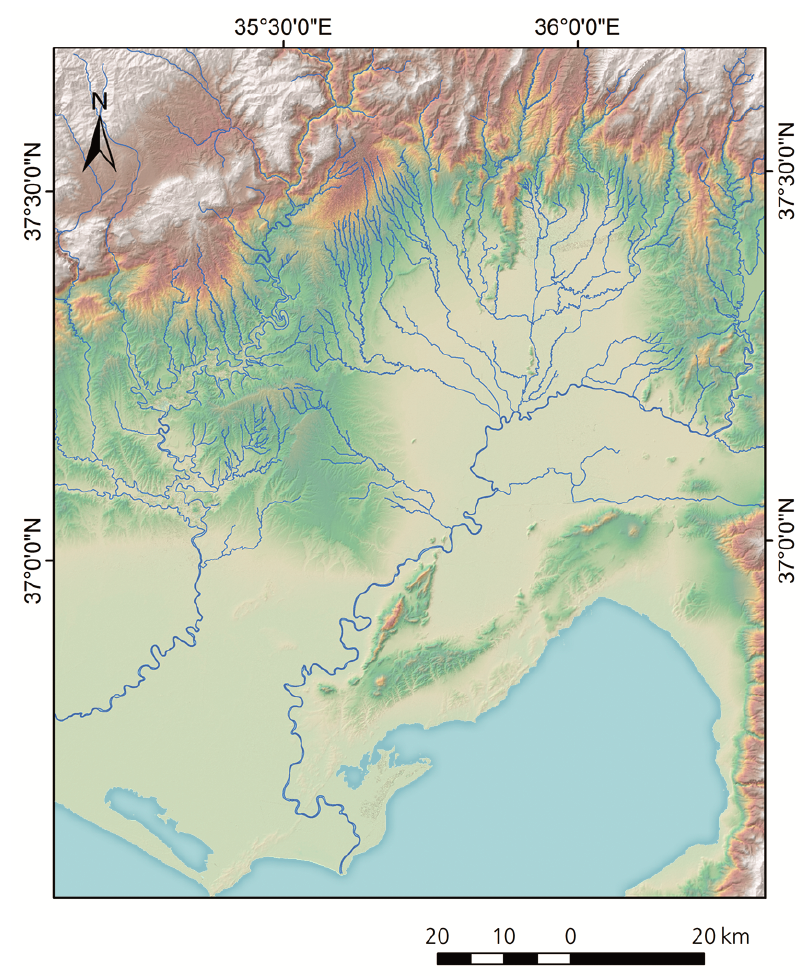
Figure 6. DEM-Mosaic based on TanDEM-X, Aster GDEM and SRTM data with modern river courses © Susanne Rutishauser.